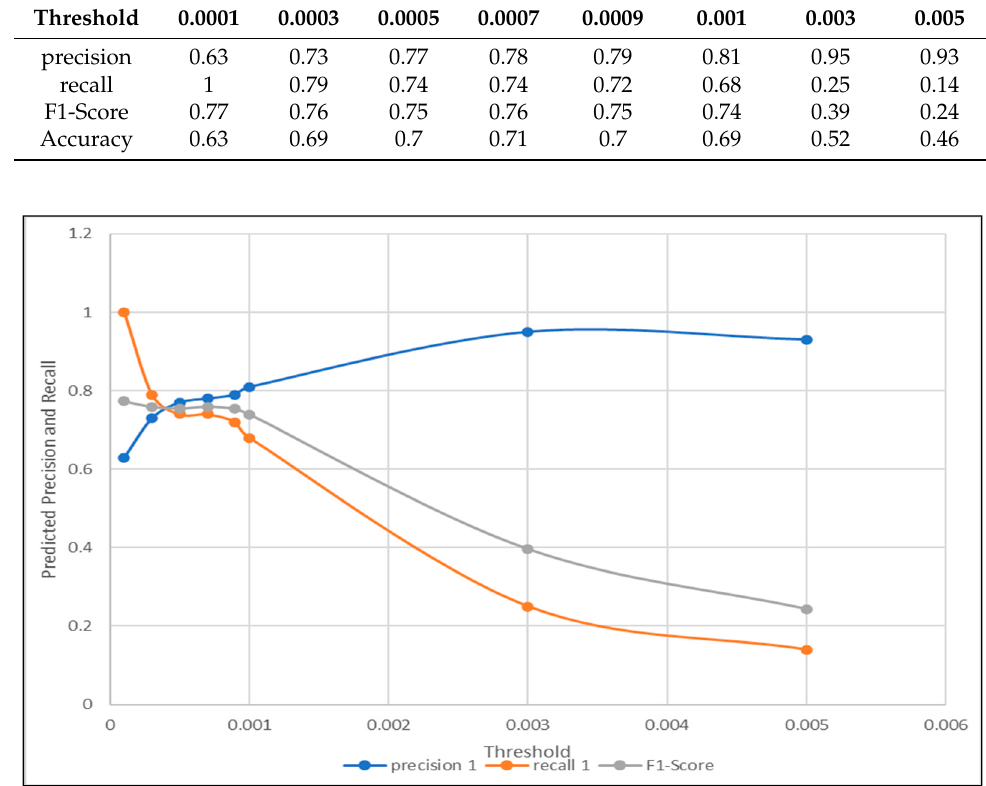
Figure 6. Precision, Recall, and f1-Score trade-off for Threshold selection using Pearson’s Correlation Difference. Table 5. The Thresholds of Pearson’s Correlation Difference and Their Corresponding Fault Detection Accuracy, Precision, Recall, and F1-Score.